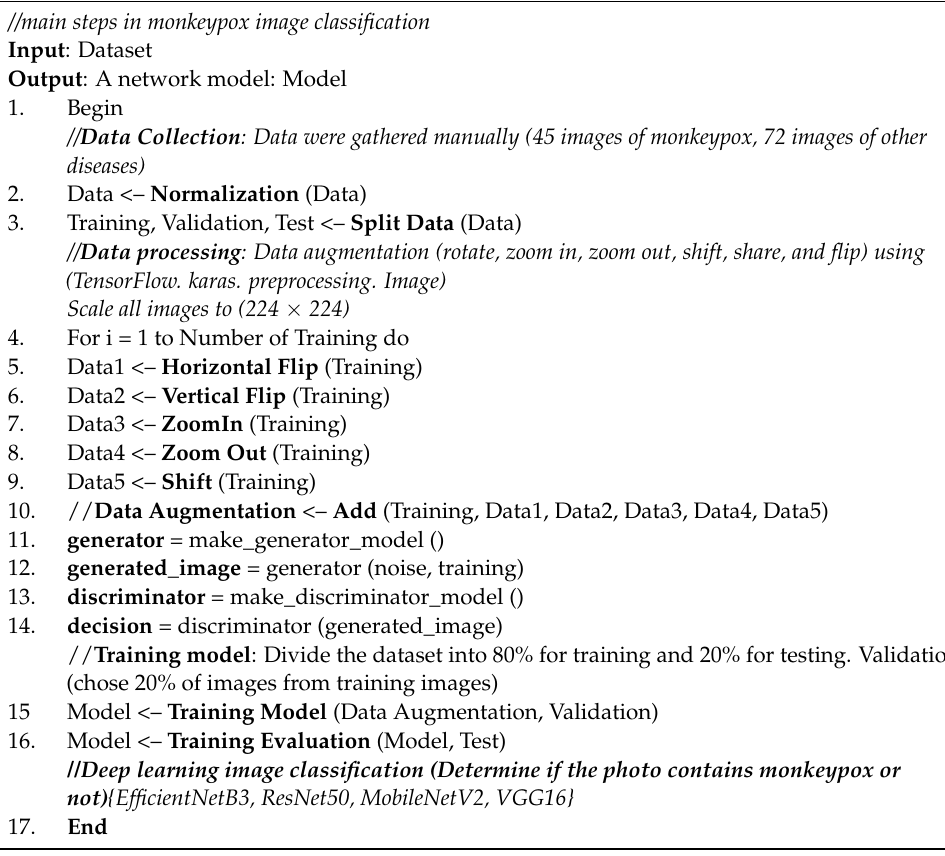
Algorithm 1: Deep Learning Image